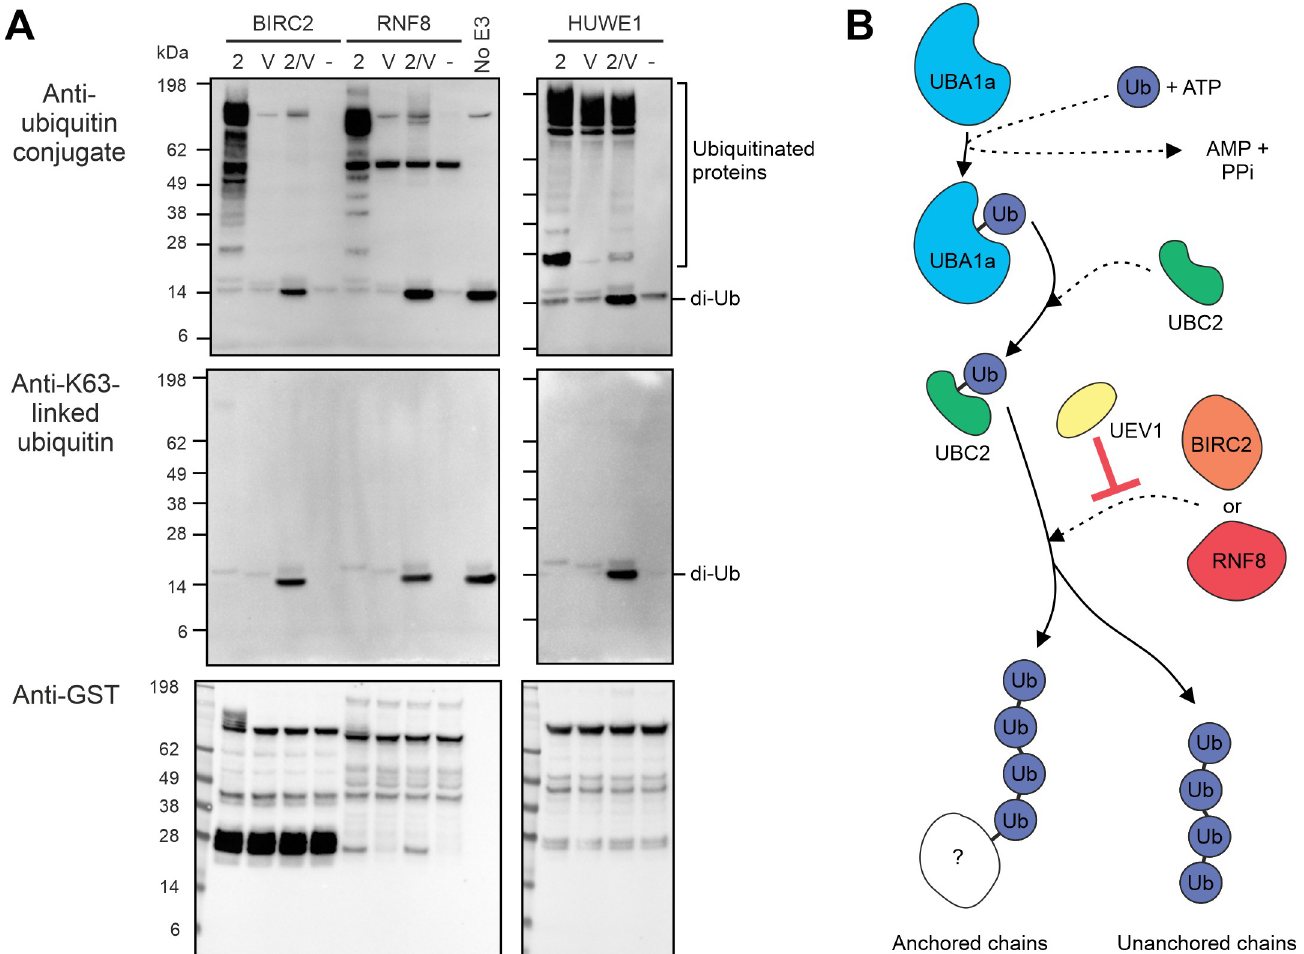
Fig 6. Cooperation of UBC2 with human E3s in in vitro polyubiquitination. A UBA1a, ubiquitin and ATP were incubated with UBC2, UEV1 and human E3s (BIRC2, RNF8 and HUWE1) as indicated in ubiquitination assay buffer for 1 h at 30˚C. Reactions were visualised by immunoblotting with either ubiquitin conjugate, K63-linked ubiquitin or GST antibodies as shown. 2, UBC2; V1, UEV1; -, no UBC2 or UEV1; no E3, no BIRC2, RNF8 or HUWE1. B Schematic summarising the findings of A . UBA1a activates ubiquitin in an ATP-dependent manner, allowing ubiquitin to bind to the active site of UBA1a via a thioester linkage. Ubiquitin is then transferred to UBC2 which can, by interacting with the human E3s BIRC2 and RNF8, form non-K63-linked polyubiquitin chains. UEV1 inhibits this association, presumably via its interaction with UBC2.